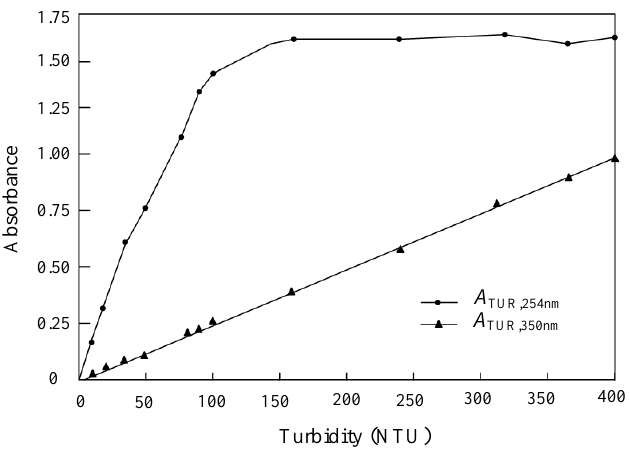
Figure 4. Absorbance curves of turbidity (TURB) at 254 nm and 350 nm.